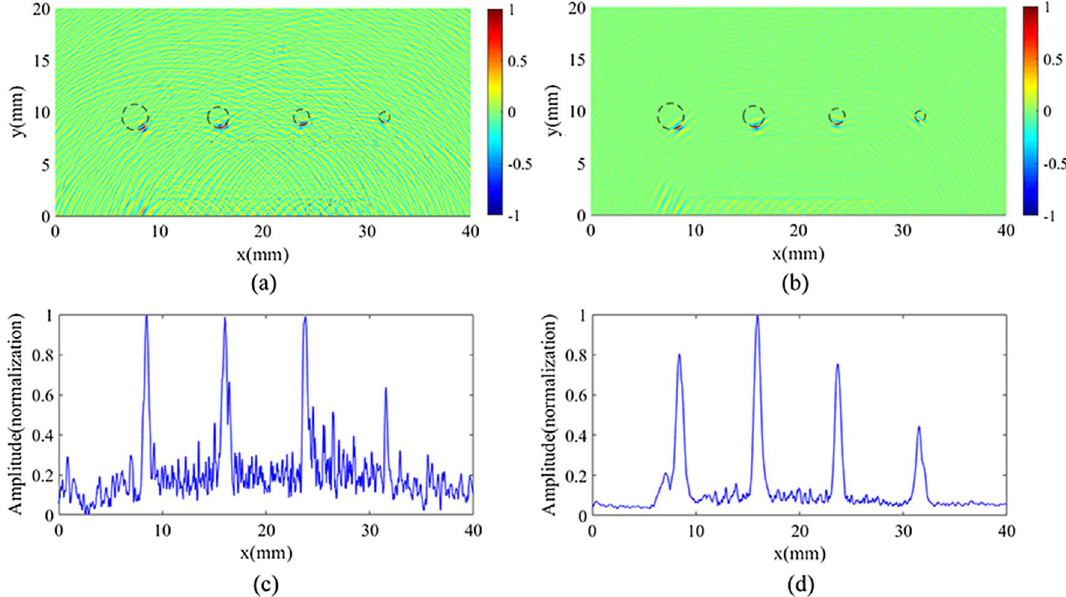
Figure 9. (a) The SAFT image after removing unwanted signals. (b) The FMC/TFM image after removing unwanted signals. (c) The maximum of the projection of SAFT along x direction. (d) The maximum of the projection of the FMC/TFM along x direction.